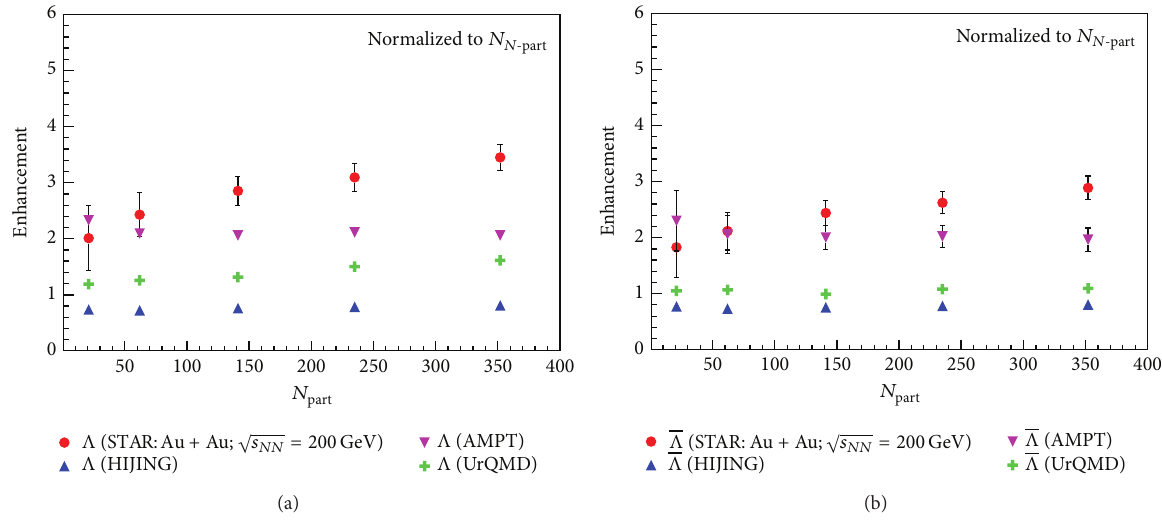
Figure 1: 𝑁 𝑁 -normalized enhancements of (a) Λ and (b) Λ as a function of collision centrality for Au + Au collisions at √𝑠 𝑁𝑁 = 200 GeV -part are compared with HIJING, AMPT, and UrQMD models at